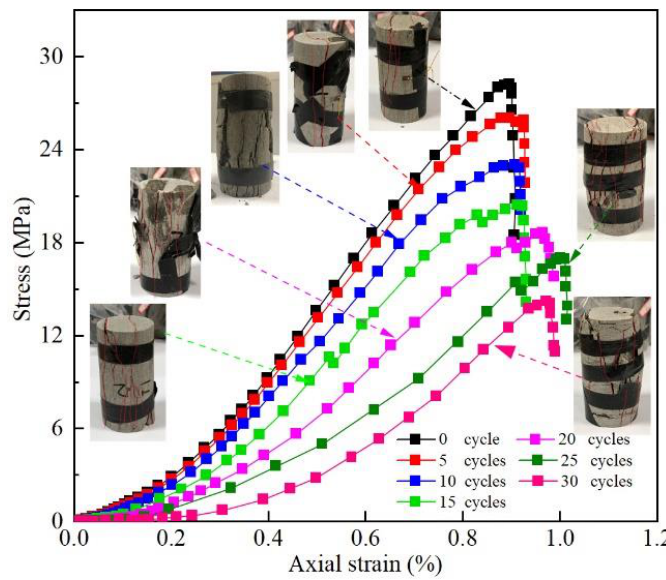
Figure 10. Stress-strain curves of the tested samples that were subjected to different F-T cycles.